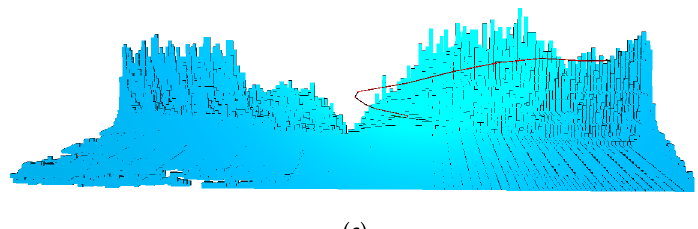
Figure 21. Trajectory generation example: The computed path is represented in red, the obstacles in blue, and the start heading and the final heading in green. ( a ) Example of emergency trajectory around Grenoble in France; ( b ) the same example seen from the other side; ( c ) other view of the trajectory to show the avoidance of the